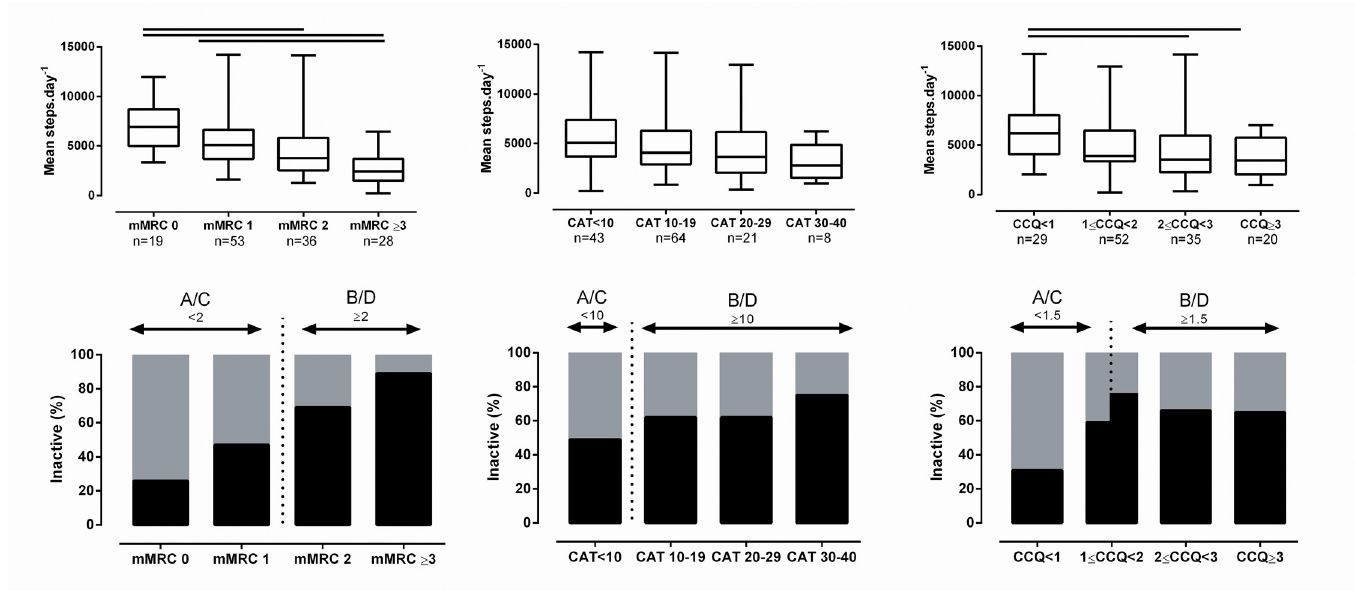
Fig 3. Physical activity across different mMRC, CAT and CCQ cut-offs. Upper panels present physical activity data, significant differences (post hoc analysis) are indicated with a solid line; lower panels depict proportion of patients defined as sedentary (black bars). Dotted line present cut off used in the GOLD classification; A/C and B/D indicate respectively quadrants A or C and B or D.